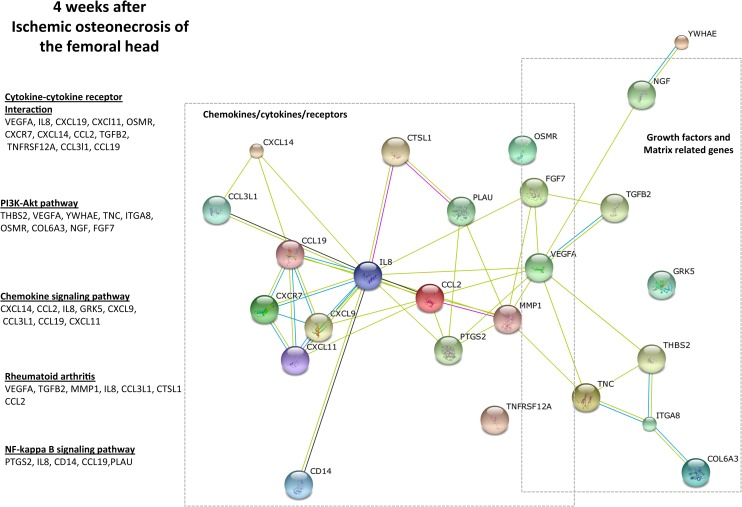
Genes involved in inflammatory response are significantly enriched in the immature articular cartilage at 4 weeks following the induction of ONFH.The genes and the pathways that were significantly enriched (p<0.05, based on t-tests, Bonferroni, FDR) belong to inflammation. The STRING10 network diagram indicates that the different genes are closely related to the inflammatory responses. The clusters of genes indicating chemokines/cytokines/receptors and the relationship to growth factors and matrix related genes show the functional link between matrix and recruitment of inflammatory cells. The nodes indicate individual genes and the connecting lines indicate the relationship. Shorter lines indicate closer relationship. The evidence plot utilizes multiple lines to indicate stronger evidence for the proximity in a functional relationship.